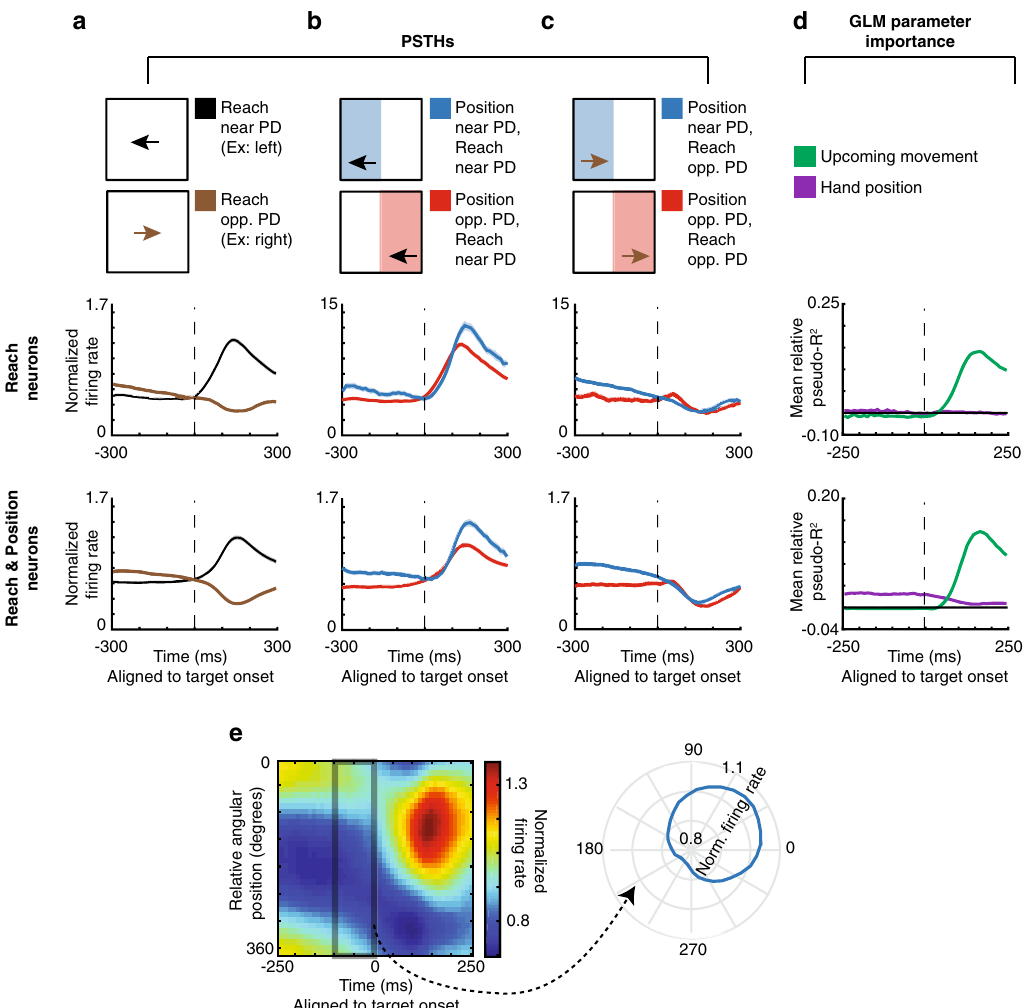
Fig. 7 M1 does not re fl ect the probability of upcoming movements. a – d PSTHs and GLM results for M1 neurons. Columns have the same schematics as Fig. 3. First row of PSTHs: Normalized averages of reach neurons, de fi ned as those neurons signi fi cant for movement during the late period, but not position in the early period of the GLM. This was the same criteria as for SR neurons in PMd. Second row: Normalized averages of reach & position neurons, de fi ned as those neurons signi fi cant for movement during the late period, and position in the early period of the GLM. This was the same criteria as for PR neurons in PMd. Note that we did not use the same “ SR/PR ” nomenclature as PMd, because there was no evidence in the PSTHs of M1 neurons that position was used to represent potential upcoming movements. e Same schematic as Fig. 4a, but for M1 reach & position neurons. Left: The normalized average fi ring rate, as a function of time and relative angular position. Activity is averaged across all reach & position neurons. Right: The normalized average fi ring rate in the 100 ms prior to target onset, plotted as a function of the relative angular hand